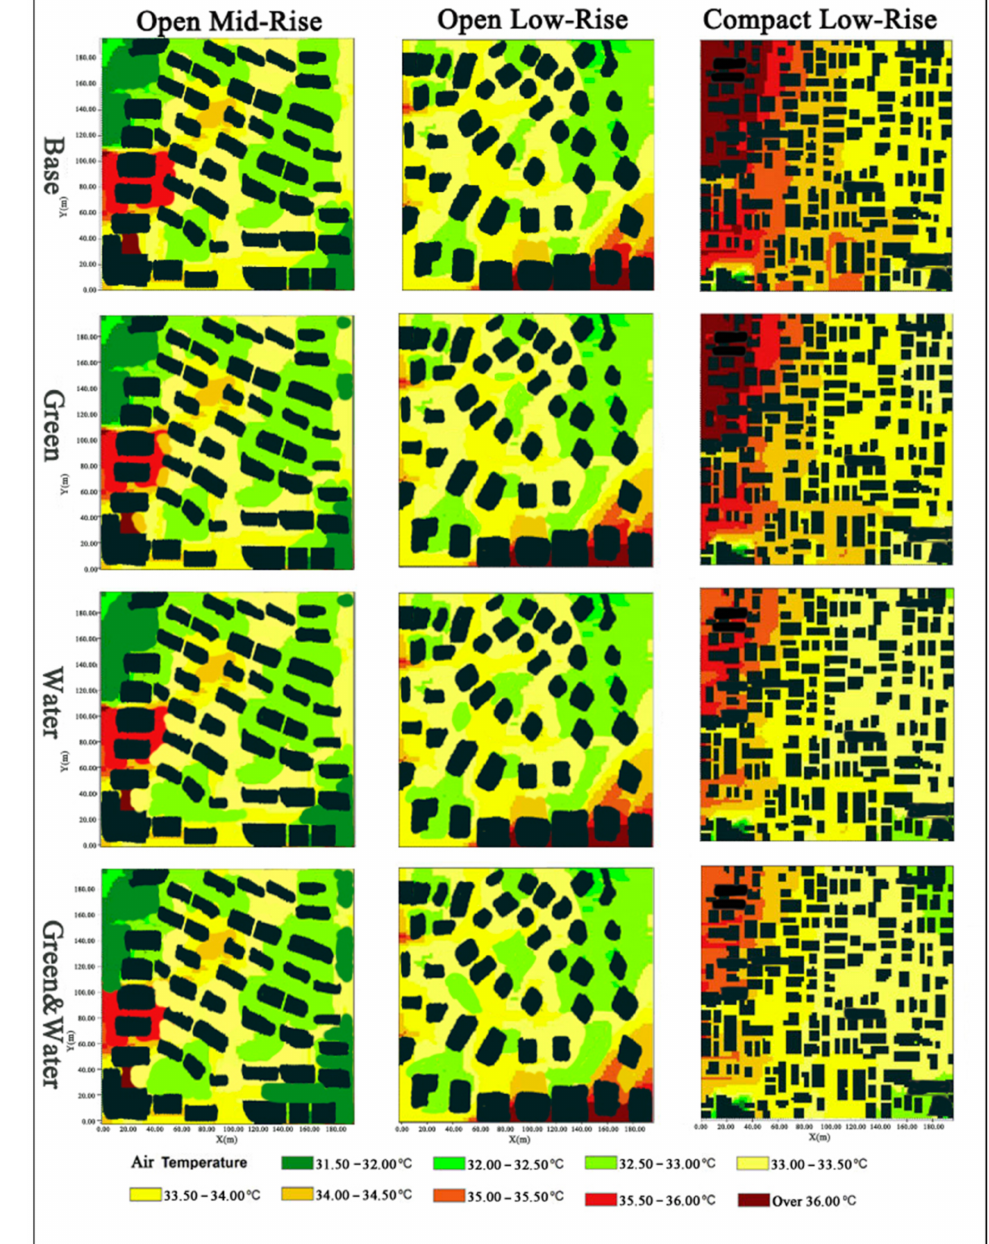
Figure 13. A 1.5 m surface temperature map of each mode at noon in summer (14:00